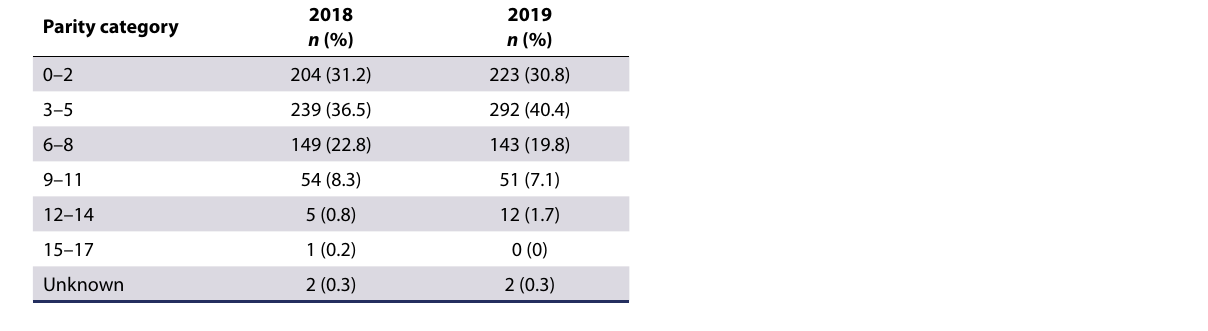
Table III: Summary of the number of individual Thoroughbred horses tested, places of examination, submitting veterinary practices and individual veterinarians by province in the 2018 and 2019 South African stud health scheme WC KZN EC NC